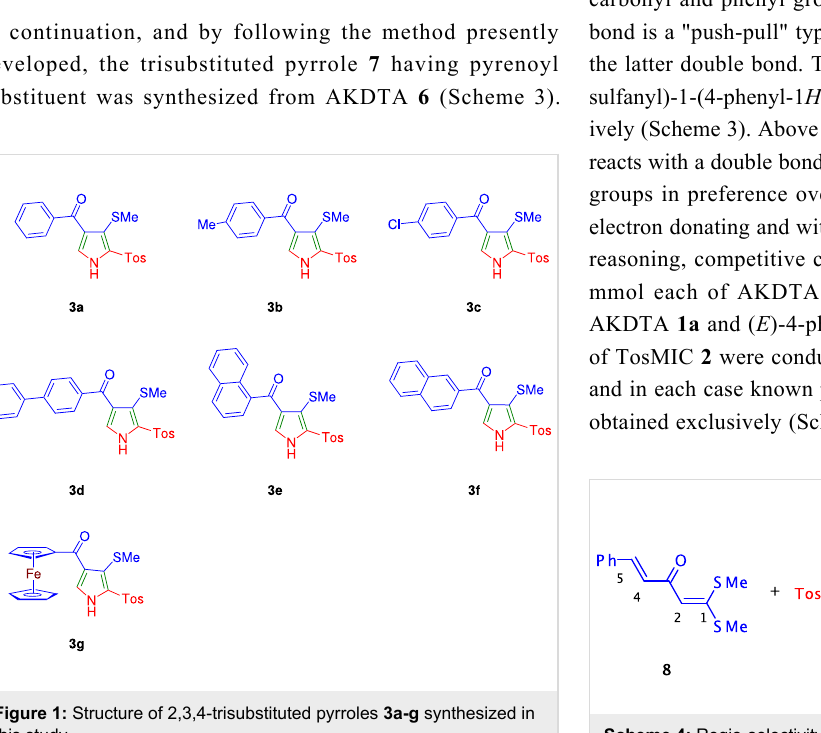
Scheme 4: Regio-selectivity in the reaction of TosMIC with 8 .